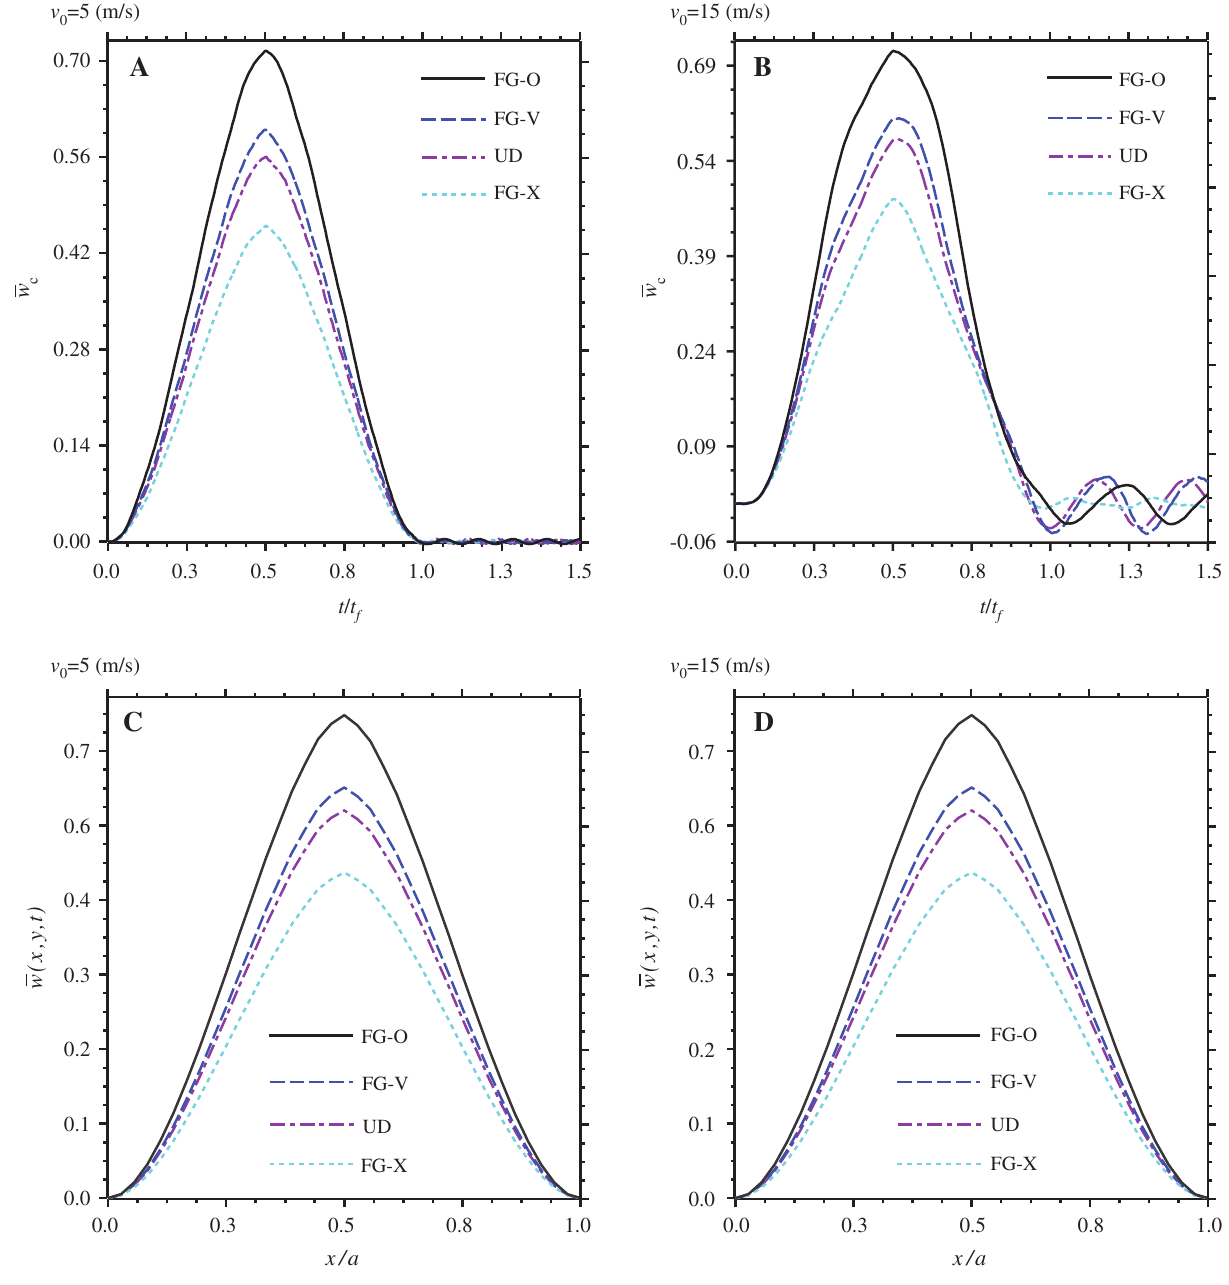
Figure 6 The influence of three different CNT distributions on the dynamic behavior of CNTRC plates with CFCF boundary conditions: (A, B) the time history of the nondimensional center deflection, (C, D) the profile of the material line y = b /2 at t = 0.5 t